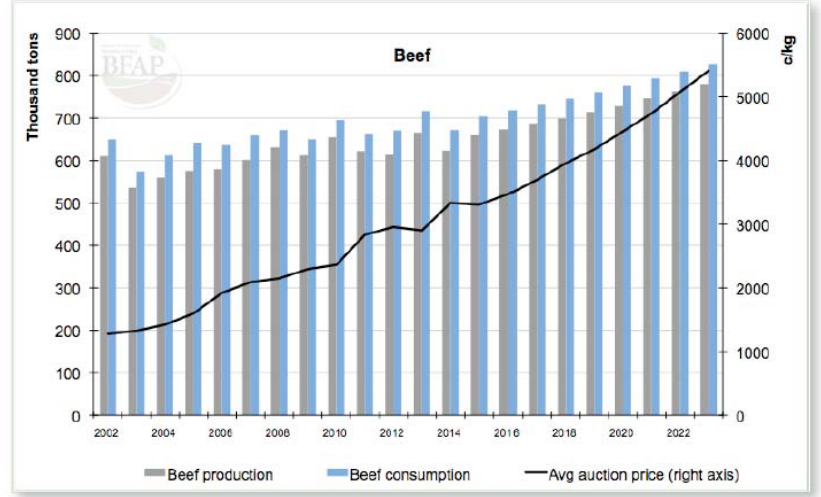
Fig. 1. SA beef production, consumption and